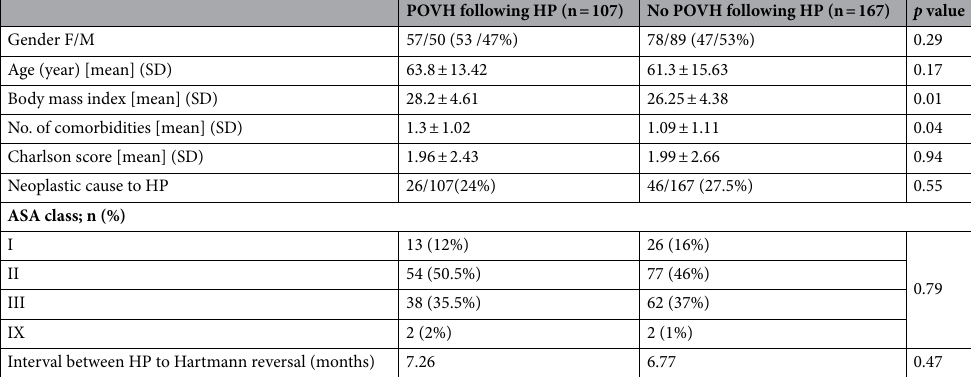
Table 1. Demographics of patients reported to have a postoperative ventral hernia (POVH) following a Hartmann’s procedure (HP), while having their colostomy reversed compared to patients without a POVH. ASA American Society of Anesthesiologists, POVH post operative ventral hernia, HP Hartmann’s